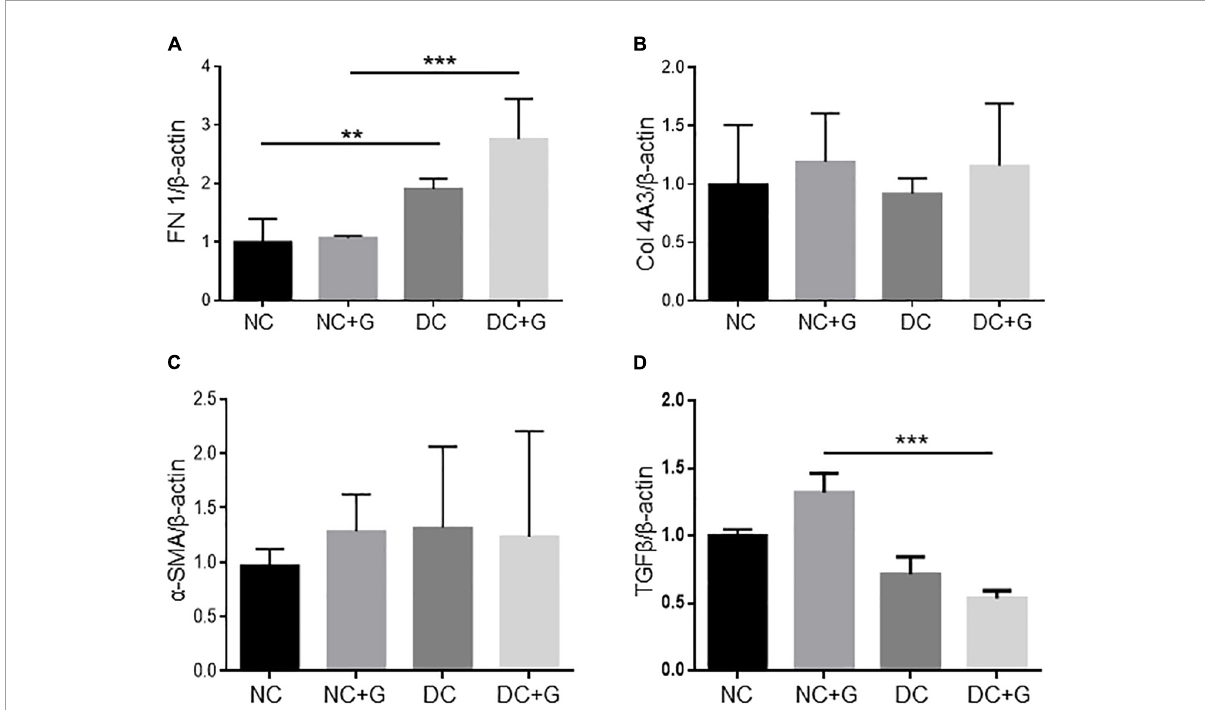
FIGURE3 Fibrotic gene expression in diabetic kidneys is unchanged upon glucosamine treatment. Real-time PCR analysis for fibrotic genes (A) fibronectin (FN-1), (B) collagen 4A3 (Col 4A3), (C) α -SMA, and (D) TGF β is shown. β -actin served as loading control. Each column shows mean ± SEM. n = 6. ** p < 0.01, *** p <